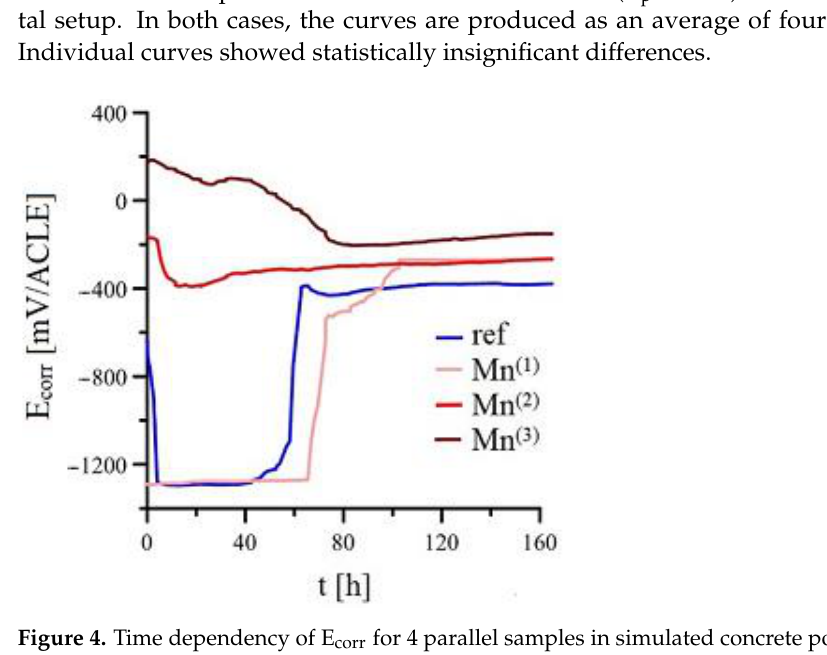
Figure 4. Time dependency of E corr for 4 parallel samples in simulated concrete pore solutions.